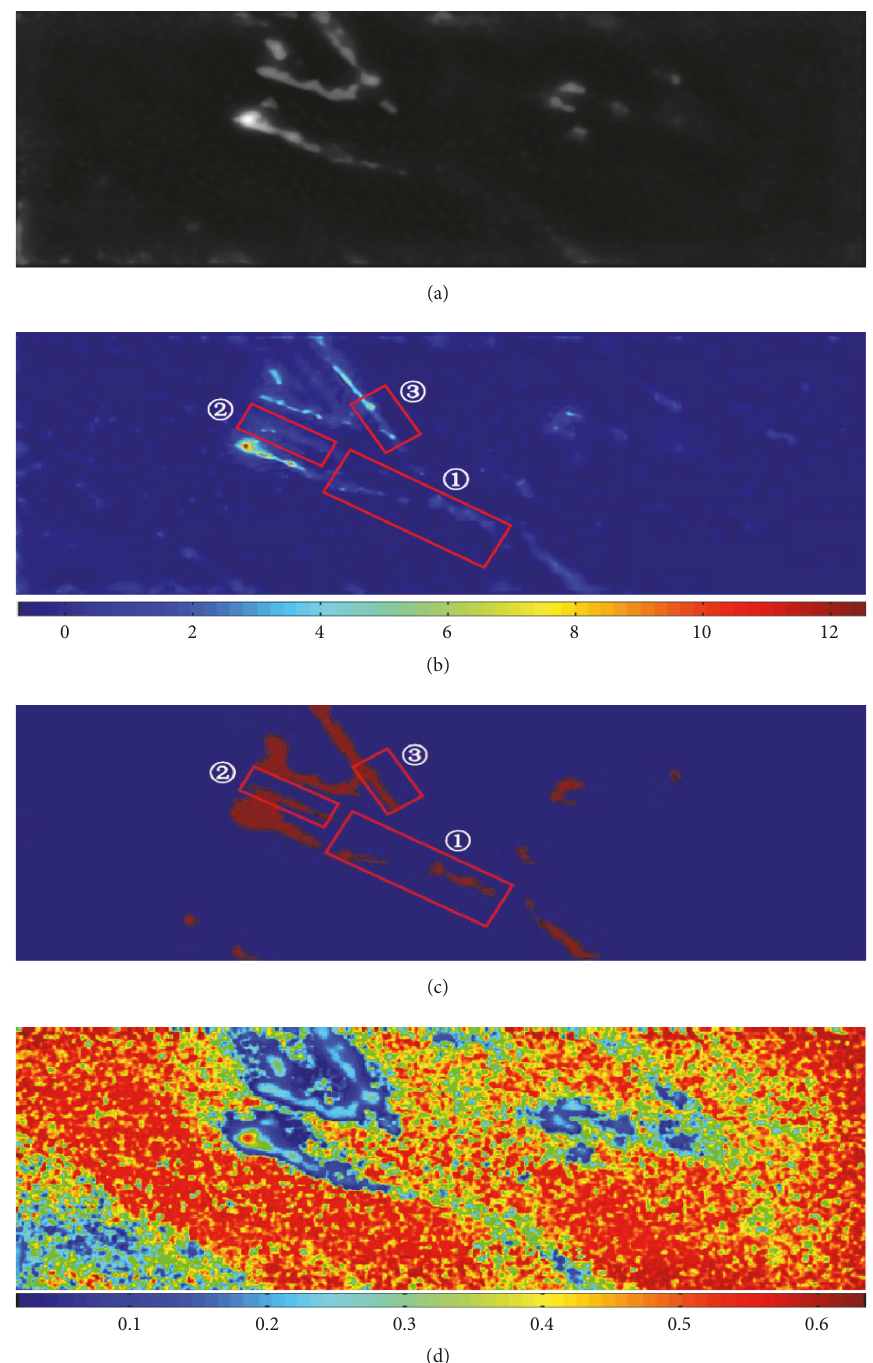
Figure 10: Extraction results obtained using our method. (a) Un-colored extracted filament. Noises are removed, and filament’s structures are retained. (b) Colored extracted filament. Compared to the filament in Figure 9(b), filament’s structures are more complete, especially in three marked places. (c) Contour extraction. (d) Residuals after the subtraction of the extracted filament from the original